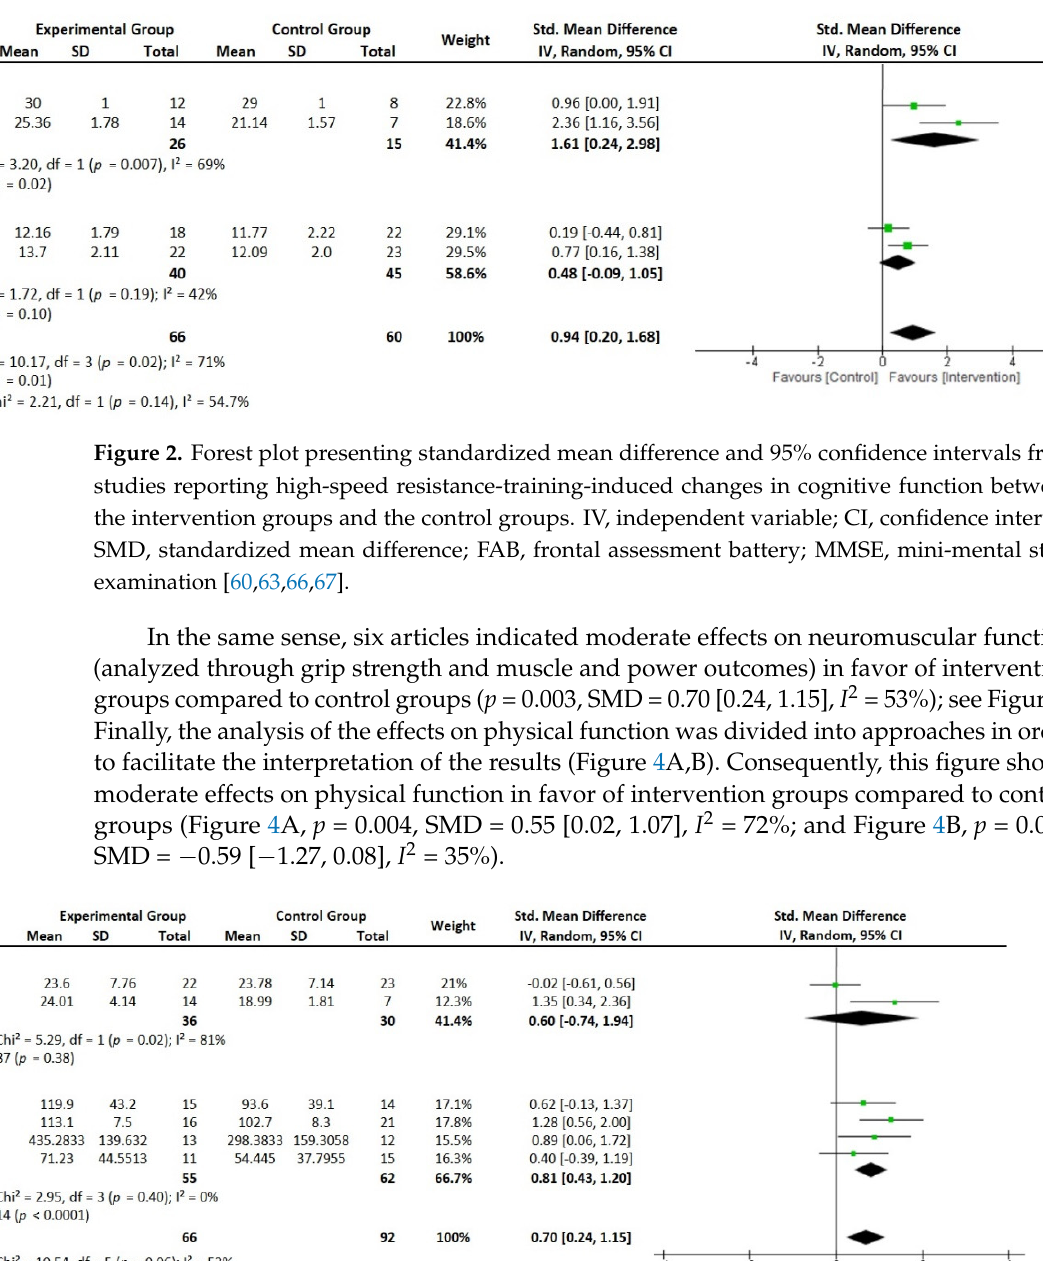
Figure 3. Forest plot presenting standardized mean difference and 95% confidence intervals from studies reporting high-speed resistance-training-induced changes in neuromuscular function between the intervention groups and the control groups. IV, independent variable; CI, confidence interval; SMD, standardized mean difference [54,57,61,65,66,67].